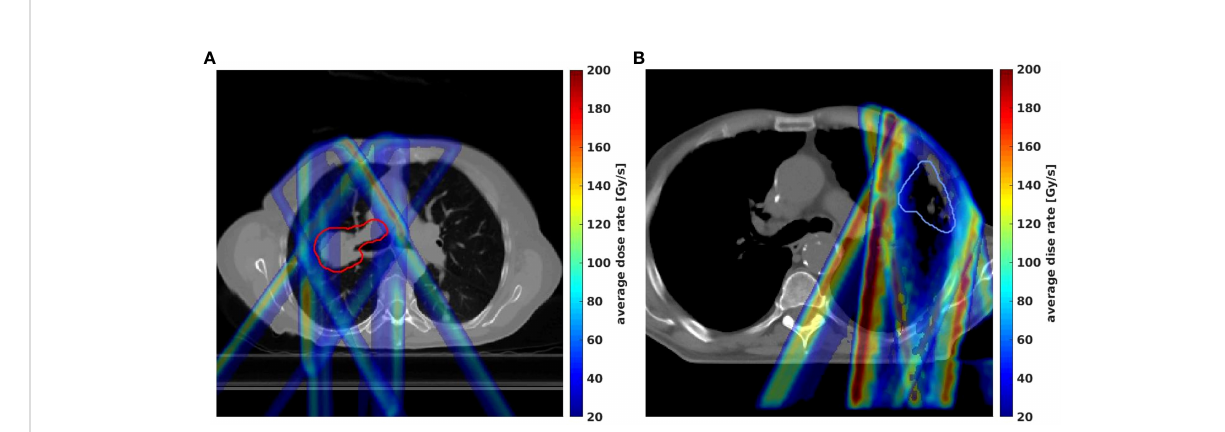
FIGURE 6 Max-min dose rate distributions in 2D from 12 different perturbation scenarios for lung patient #1 (A) and patient #2 (B) were demonstrated by the Trx-3fds plans.